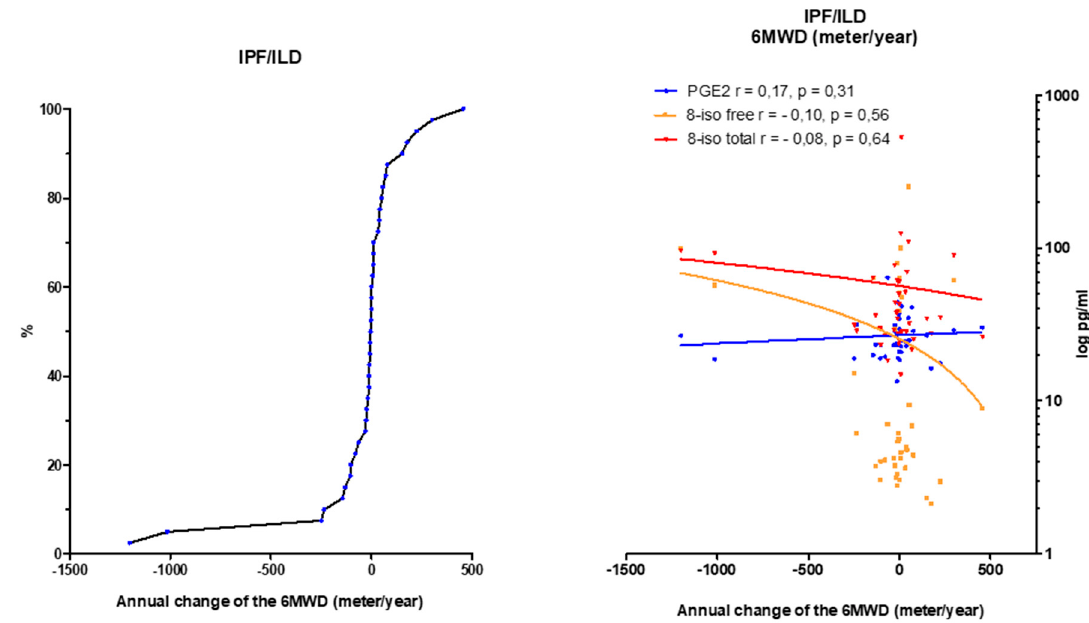
Figure 5. Correlation of the annual change in 6MWD (meter / year) in IPF and ILD patients and PGE2, total and free 8-isoprostane values in BALF. Left panel: The annual change of the 6MWD is summarized in the cumulative frequency diagram. Right panel: Correlation of 6MWD to PGE2 and 8-isoprostane. Abbreviations: 6MWD: walking distance in six minutes, PGE2: prostaglandine E2, r: correlation coefficient according to Spearman, 8-iso: 8-isoprostane. If data was not available from all patients, the number(s) is specified.